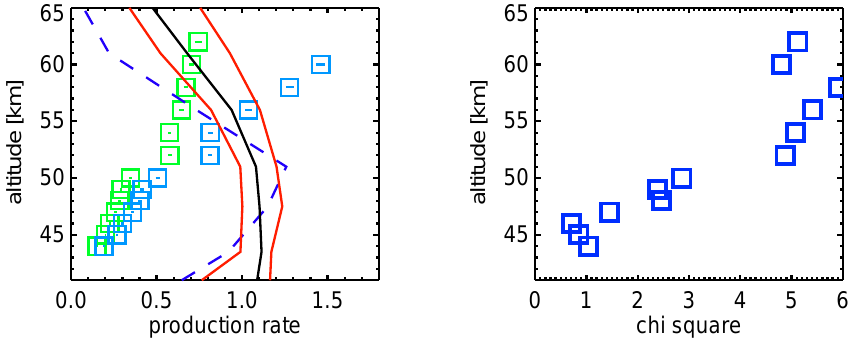
Fig. 4. Left: the effective NO x -production rate per ion pair x in dependence of the altitude at a geomagnetic latitudes between 50 ◦ S and 90 ◦ S. x (green symbols) is the gradient of the fit shown as green line in Fig. 3 (right panel). The blue symbols show x calculated without electron ionization rates. The error bars show the 1- σ range of the effective production rates. The black curve shows the effective daytime NO x -production rate per ion pair, calculated with a box model. The red curves show the error range after varying the initial values of this box model as described in Sect. 4.1. The violet dashed curve shows the effective daytime NO x -production rate, calculated with the initial N- and NO-production rates determined by Baumgaertner et al. (2010). Right: the altitude-dependent reduced residual χ 2 of the fits related to the green line in Fig. 3 (right panel) corresponding to the green symbols